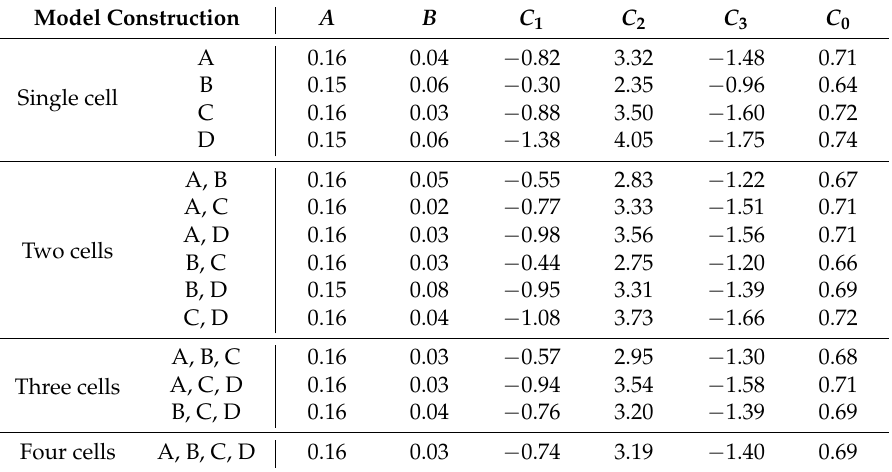
Table 4. SOH model and α ’s coefficients using different cell(s) as training